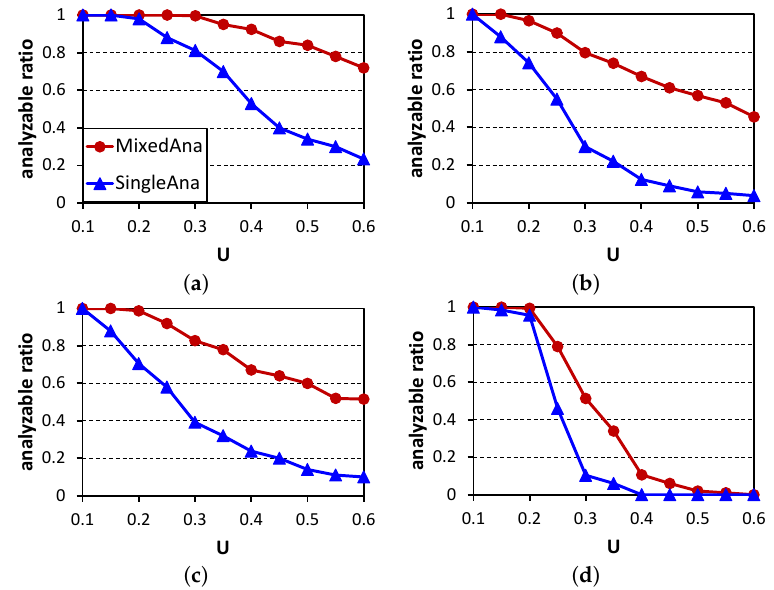
Figure 10. Schedulability comparison among analyzing algorithms. ( a ) | N | = 20, M = 6, ρ = 0.1; ( b ) | N | = 20, M = 6, ρ = 0.3; ( c ) | N | = 20, M = 9, ρ = 0.1; ( d ) | N | = 60, M = 6, ρ = 0.1. MixedAna, mixed criticality